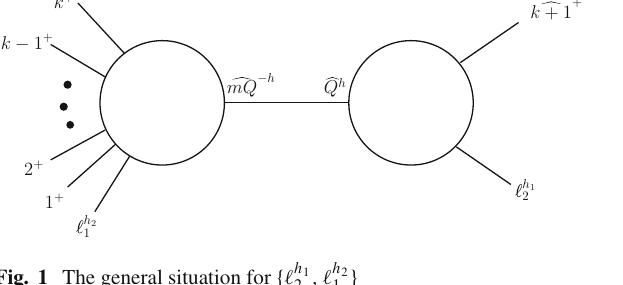
Fig. 1 The general situation for { (cid:2) h 1